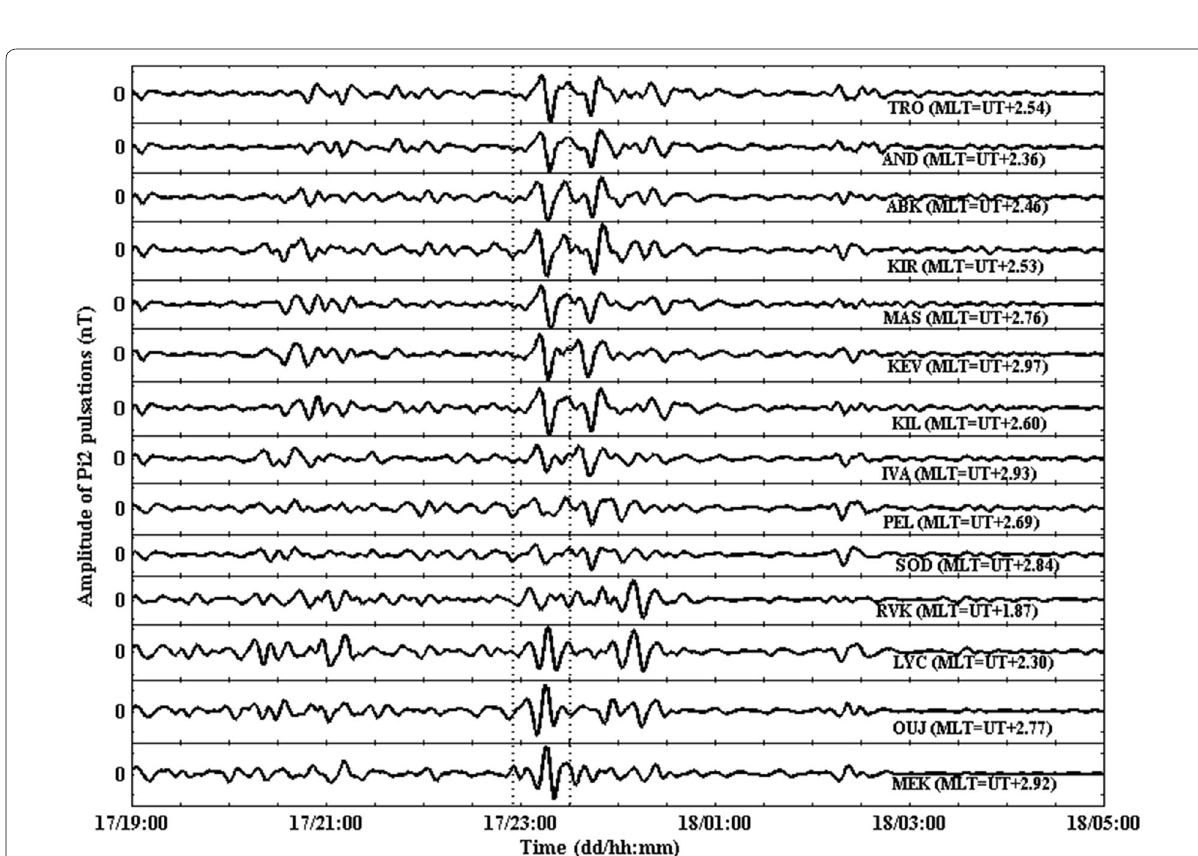
Fig. 4 Temporal profile of Amplitude of Pi2 pulsations associated with magnetospheric substorm during 17–18 March 2015. The tick marks below and above “0” in each panel indicate 200 nT and 200 −